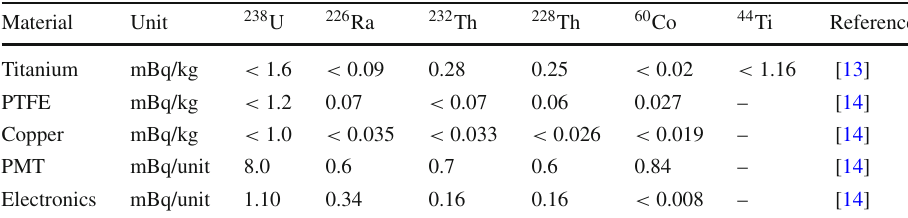
Table 2 Assumed activity levels for the simulated materials and isotopes